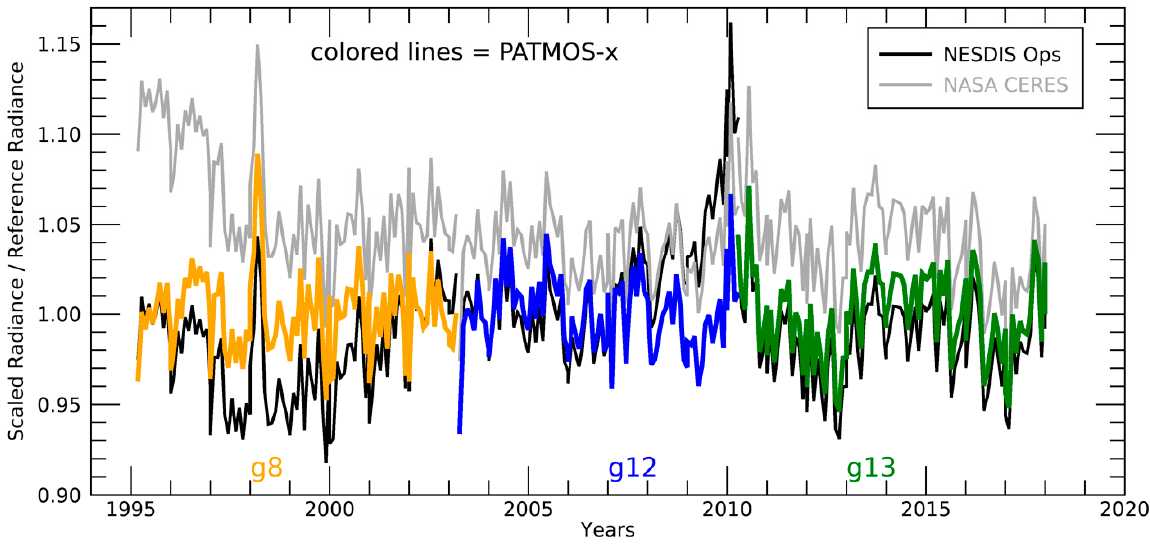
Figure 7. Time series of the integrated FD scaled radiance for GOES-East. Thin black line is the ABI reference. Thick colored lines are the values for each satellite from the PATMOS-x calibration derived here. Gray line shows the NESDIS operational calibration, and the black line shows the NASA CERES Ed4 calibration.